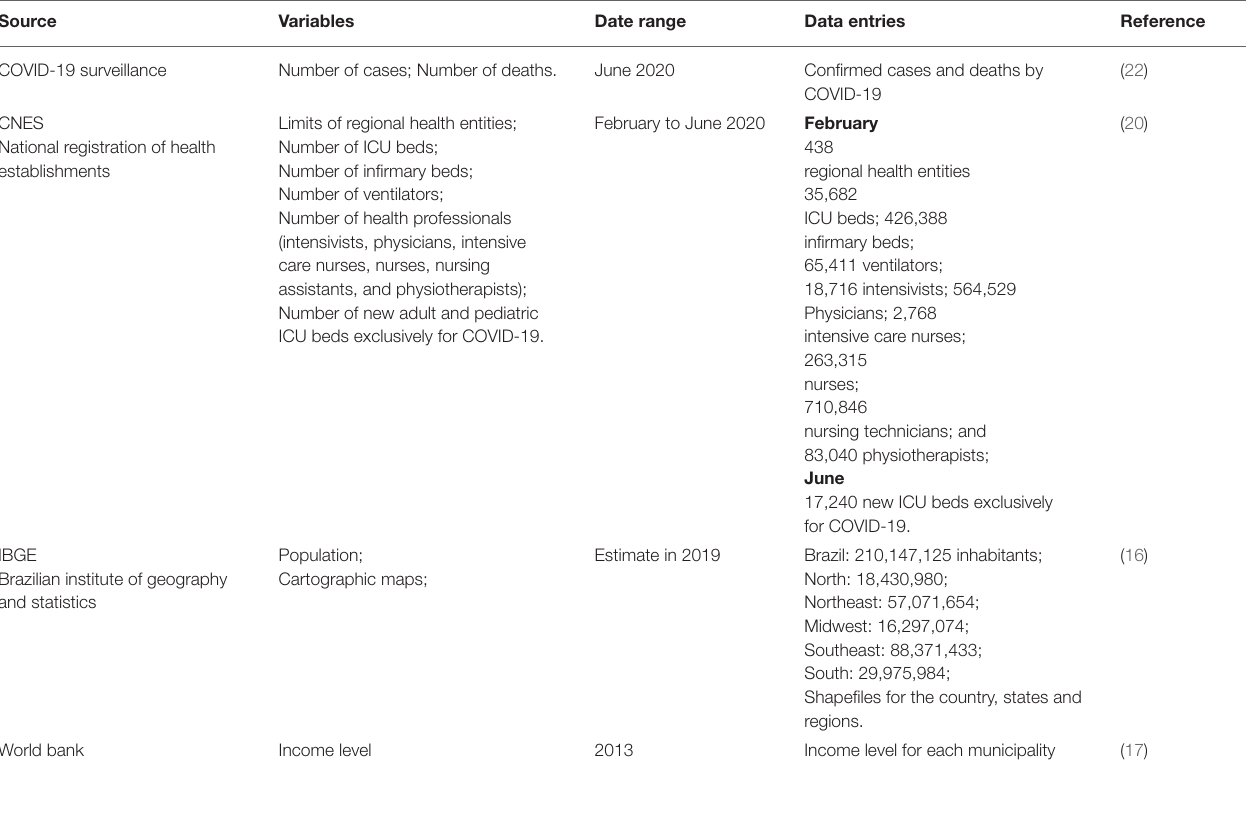
TABLE 1 | Data source, variables, date, and data used to develop this research in Brazil,